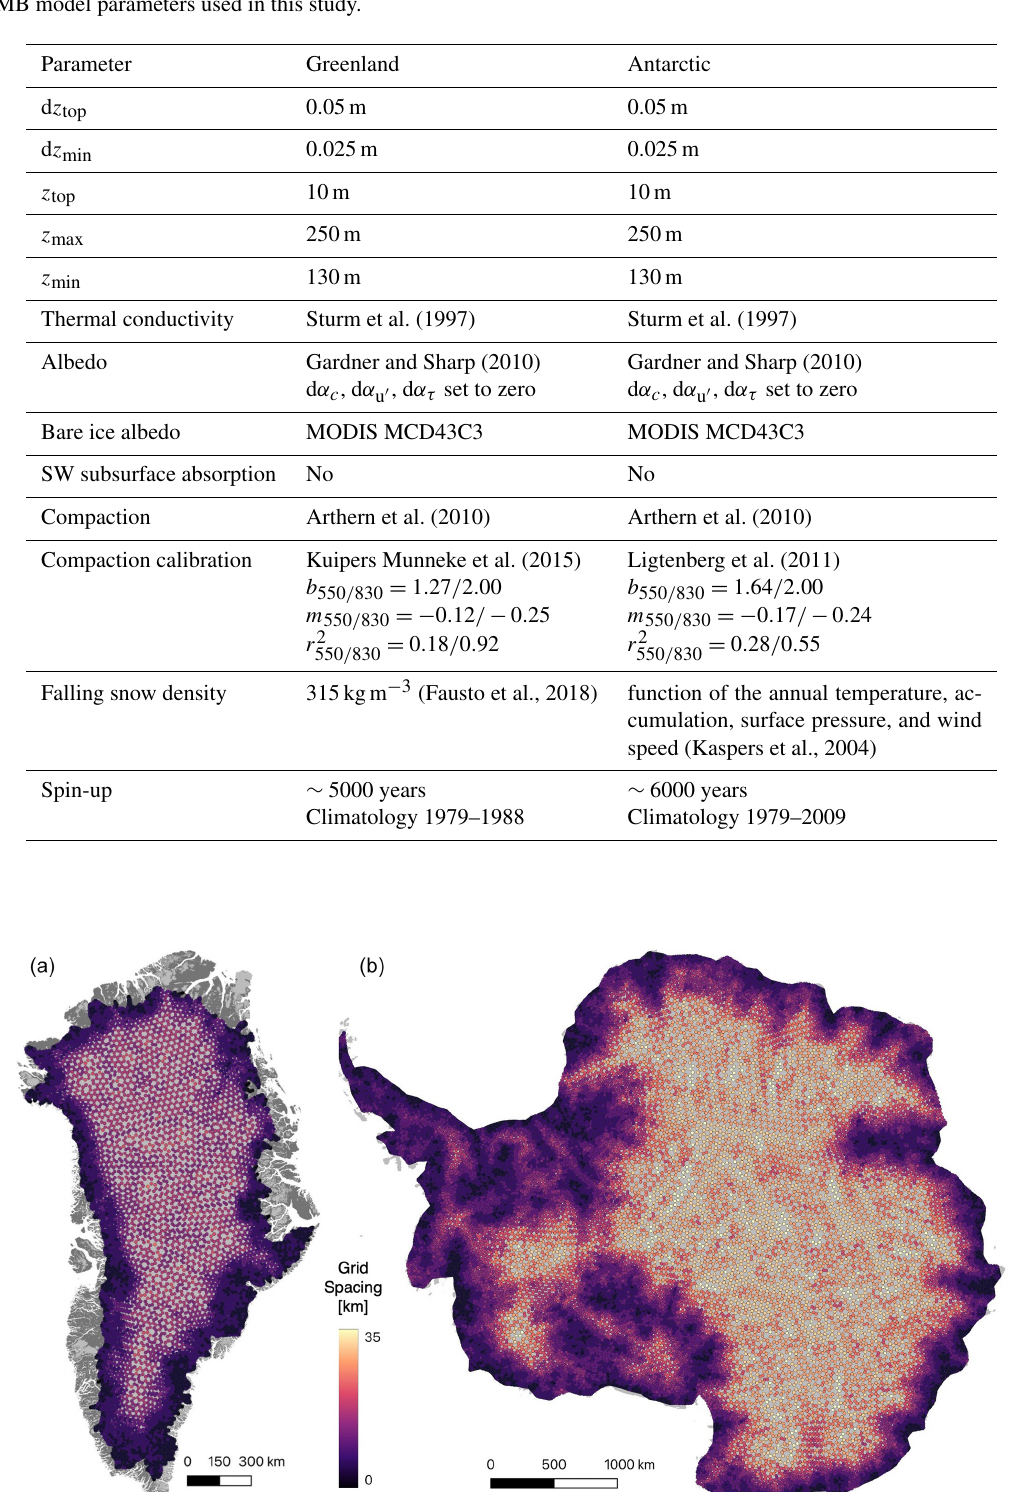
Geosci. Model Dev., 16, 2277–2302,